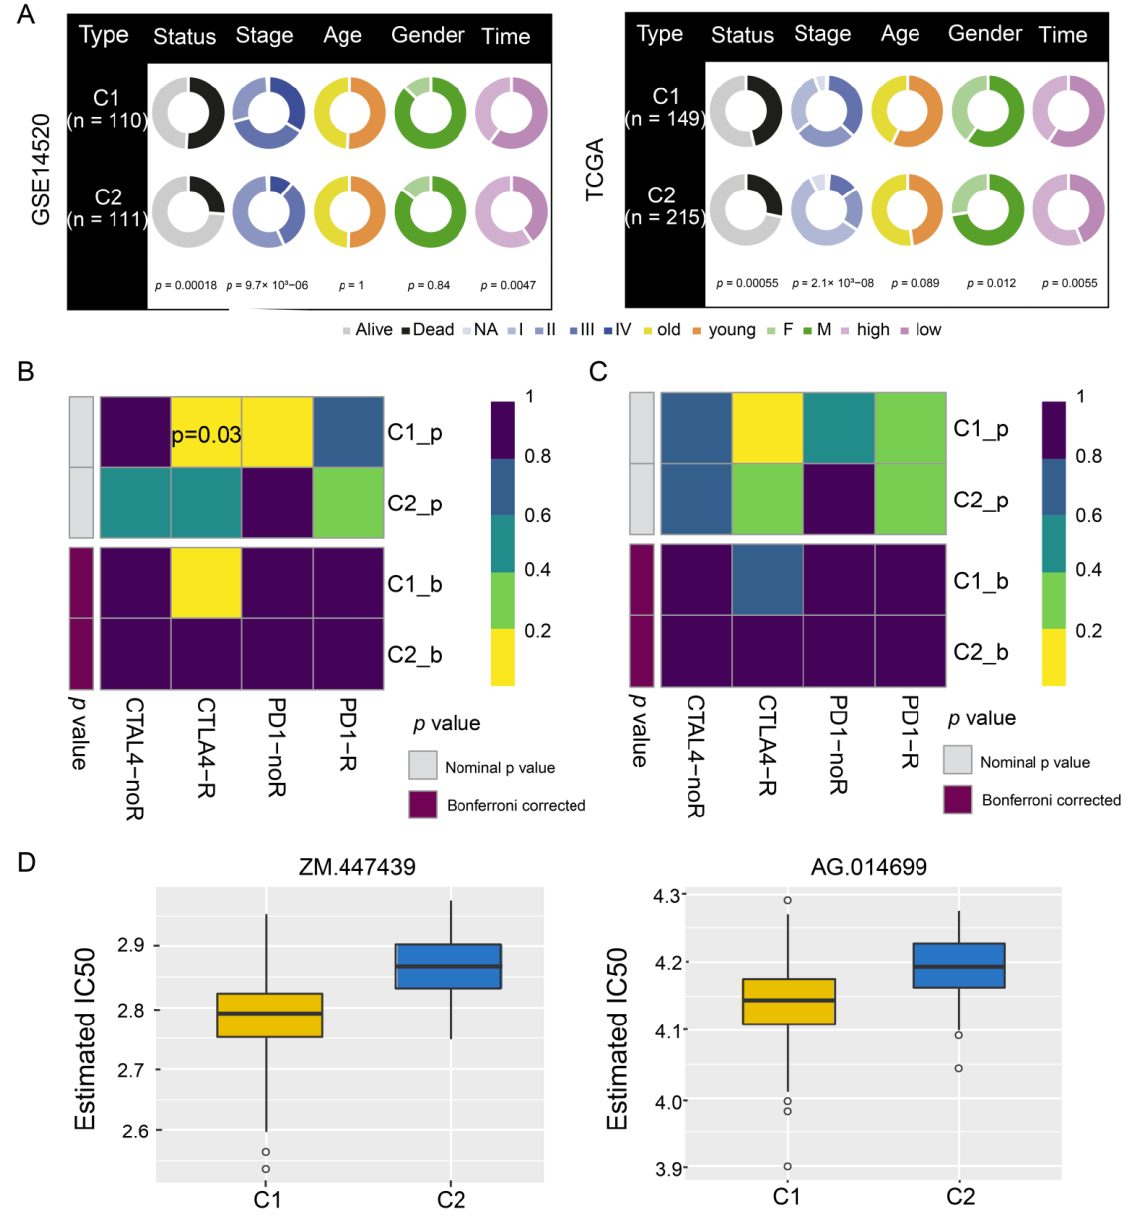
Figure 6. Drug sensitivity and immunotherapy response of hepatocellular carcinoma subtypes C1 and C2. ( A ) Pie charts comparing the distribution of clinical data between the two subtypes in the GSE14520 and TCGA datasets. ( B , C ) Responsiveness of subtypes to immunotherapy in ( B )